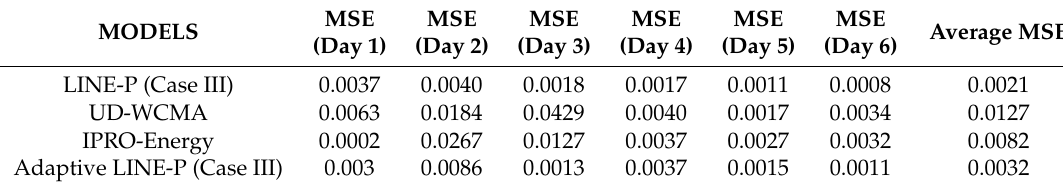
Table 7. Error comparison of prediction models based on the MSE by deploying PG&E solar